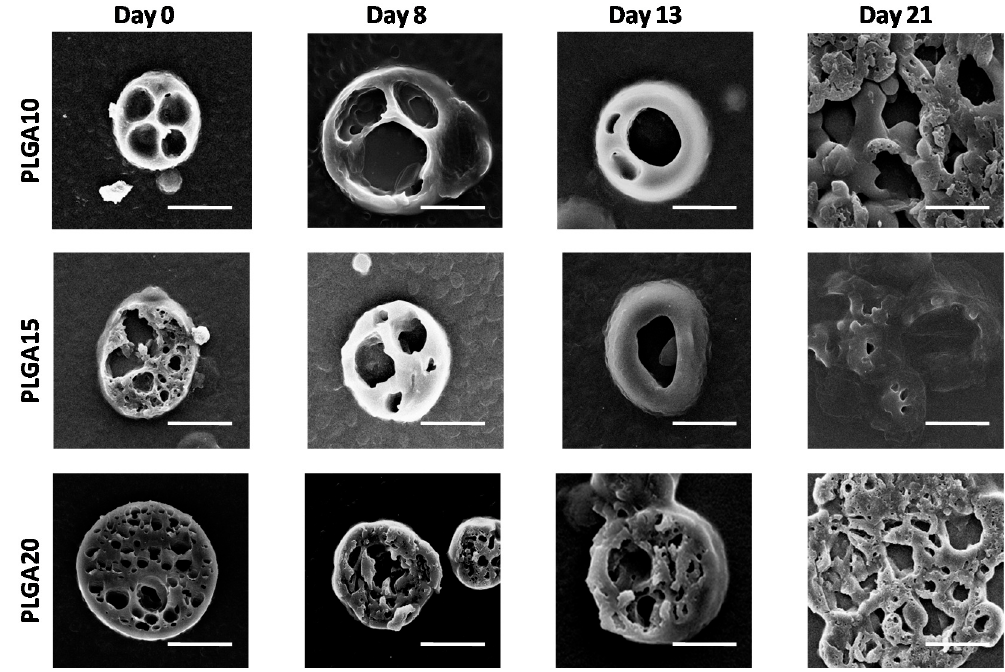
Figure 2. SEM images of cross sections of degrading MS. The formation of large pores within MS bulk in time is evidenced. The bar is 10m.